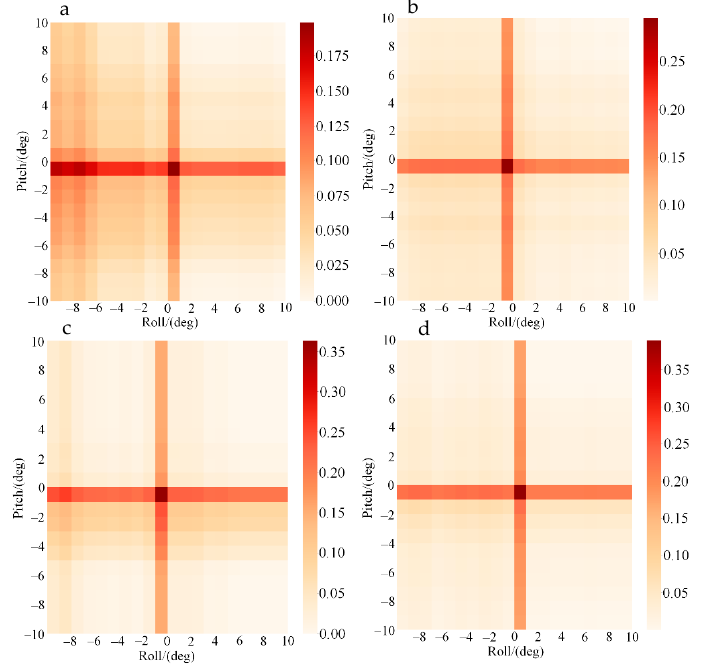
Figure 13. The attitude heat maps of the quadrotor. ( a ) Under the PID controller; ( b ) under the ICPID controller; ( c ) under the ADRC controller; and ( d ) under the ICADRC controller.